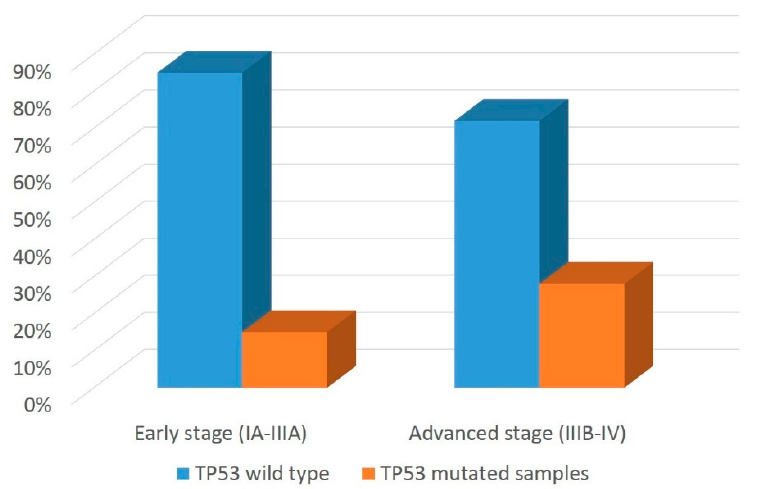
Figure 4. TP53 status in EGFR mutated cases in early- and advanced-stage tumors. Bar graphs show the percentage of EGFR -mutated samples with either wild-type or mutated TP53 genotype.